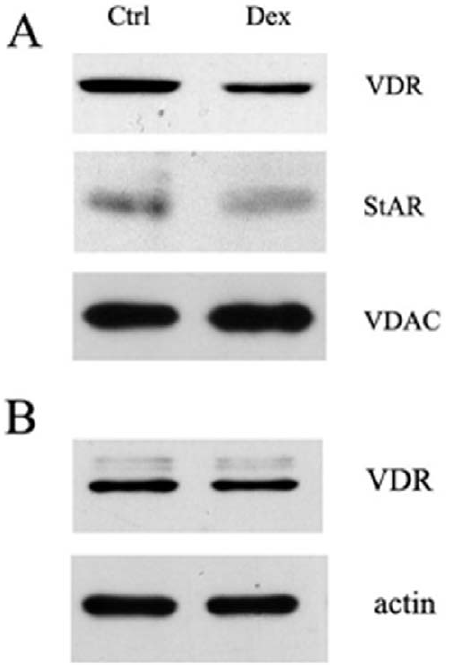
Figure 5. Western blot analysis of the expression of VDR and StAR upon dexamethasone treatment. 30 m g of mitochondrial proteins (A) or whole lysates (B) from untreated HaCaT cells (ctrl) and cells treated for 72 h with dexamethasone (Dex) were analysed by western blotting using an antibody anti-VDR, followed by immuno- staining with anti-StAR and finally with anti-VDAC or anti-actin antibody for loading control. The blots are representative of a set of three independent experiments.